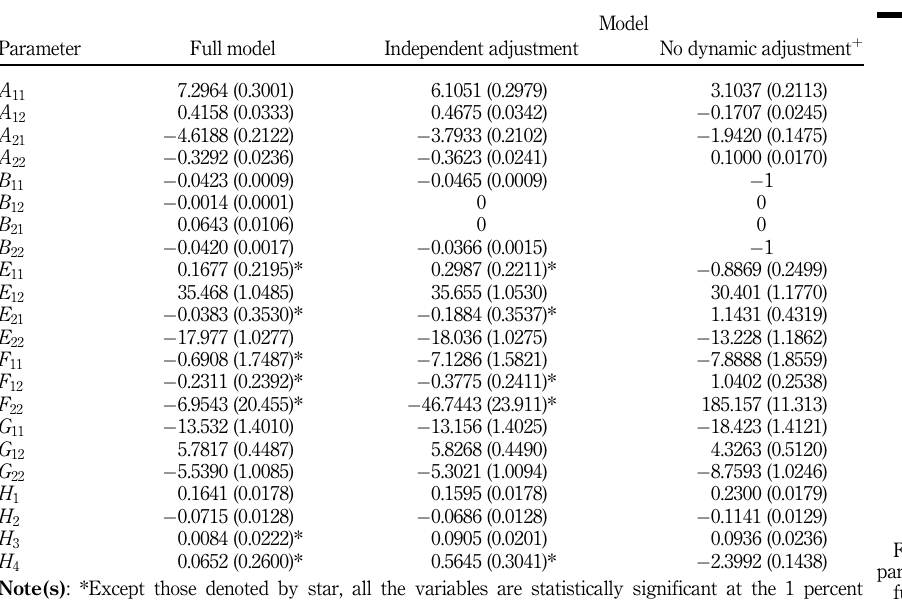
Table I. FGNLS estimates